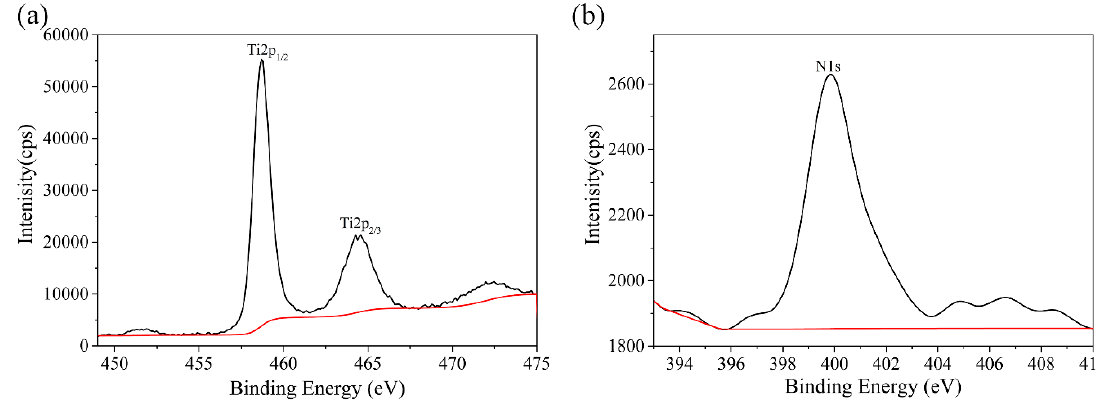
Figure 4. XPS spectra of Ti ( a ) and N ( b ) of TiO 2 / Aphen.